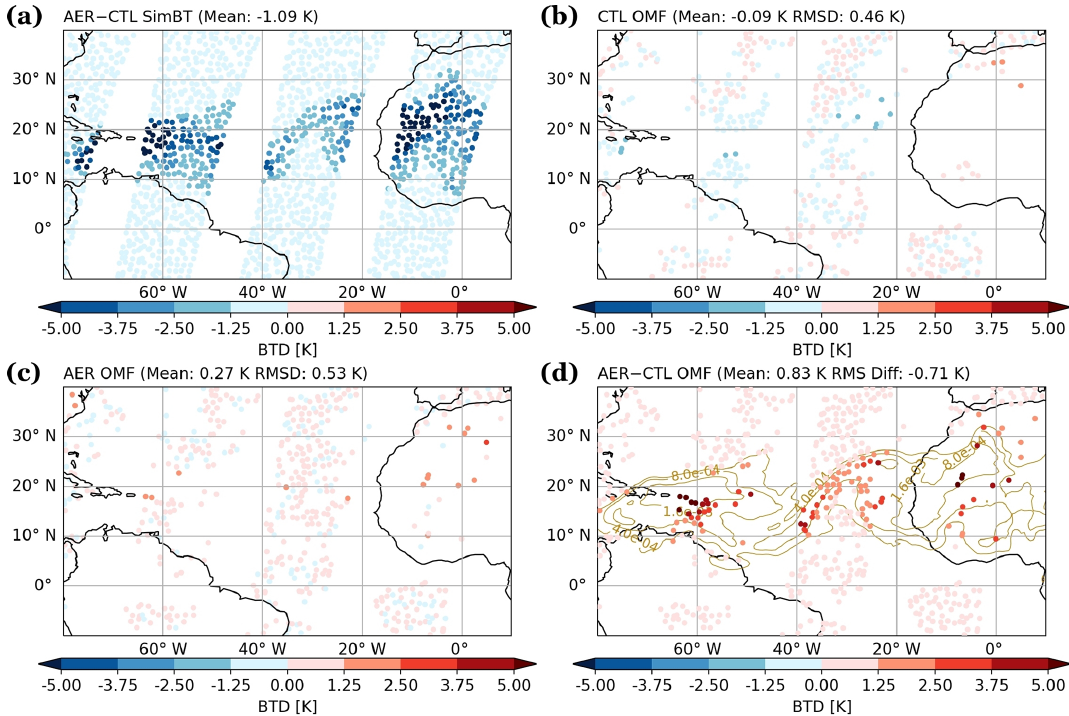
Figure 3. (a) Simulated BT differences (AER − CTL), (b) bias-corrected OMF from the CTL experiment, (c) bias-corrected OMF from the AER experiment, and (d) OMF differences (AER − CTL) for 10.39µm channel of IASI on board METOP-A. All the data are from the analysis cycle at 12:00Z on 22 June 2020. Contours of total column mass density from MERRA-2 are plotted in panel (d) .